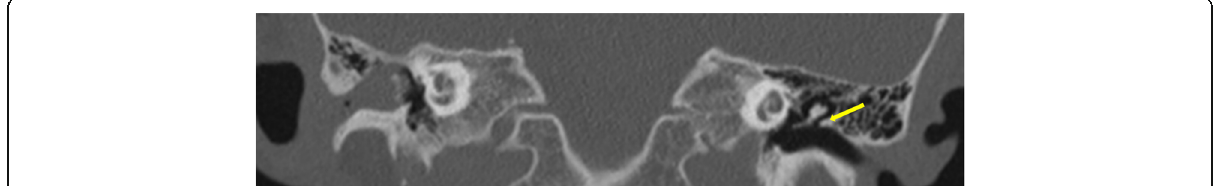
Fig. 2 Coronal CT image showing normal scutum on the left side (arrow). It is seen as a point of superior attachment of the tympanic membrane. Scutum is eroded on the right side with soft tissue seen in the middle ear and external auditory